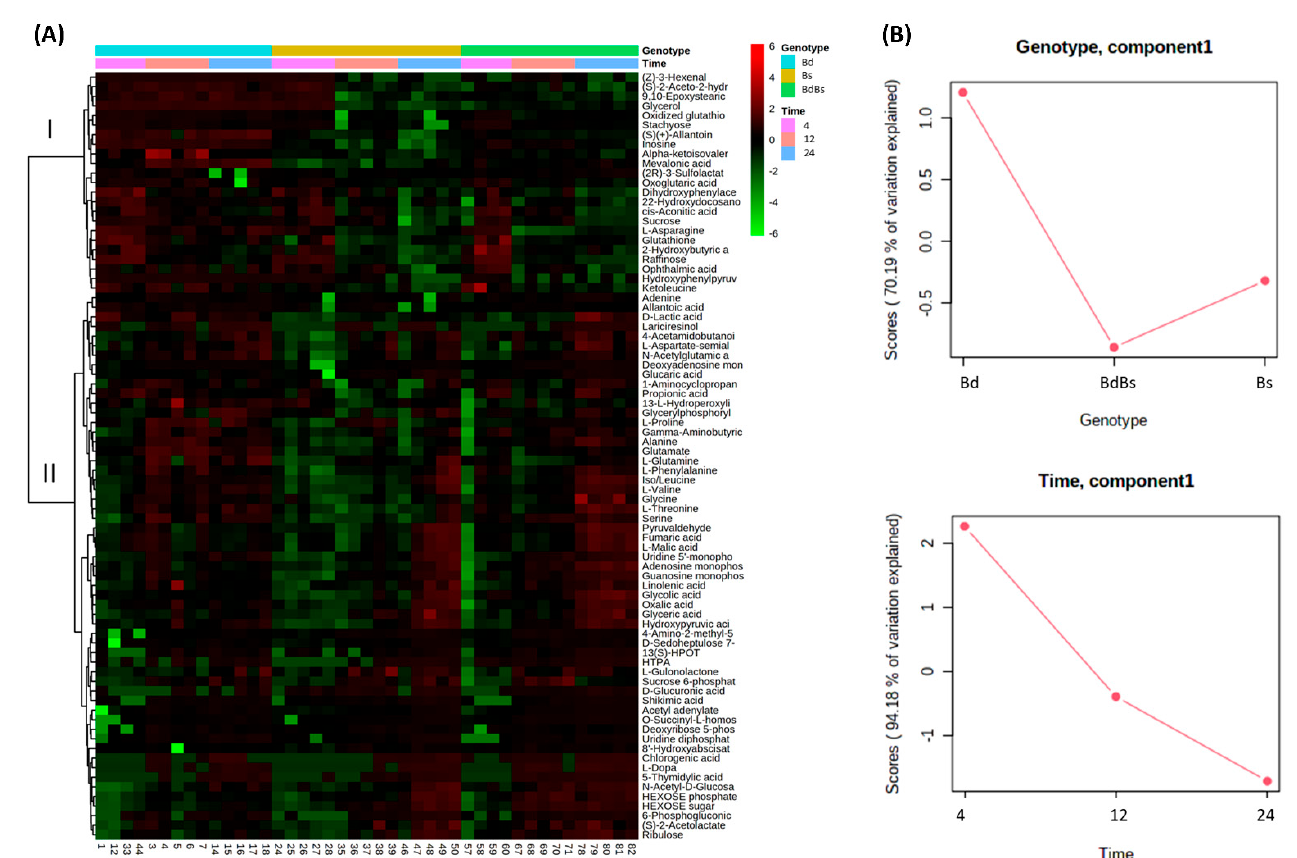
Figure 5. Metabolomic variation in Brachypodium embryos during germination. ( A ) Heatmap of major sources of metabolite variation and ( B ) ANOVA–simultaneous component analysis showing effect estimates (genotype and time) in B. distachyon Bd21 (Bd), B. stacei ABR114 (Bs), and B. hybridum ABR113 (BdBs) at 4, 12, and 24 HAI.